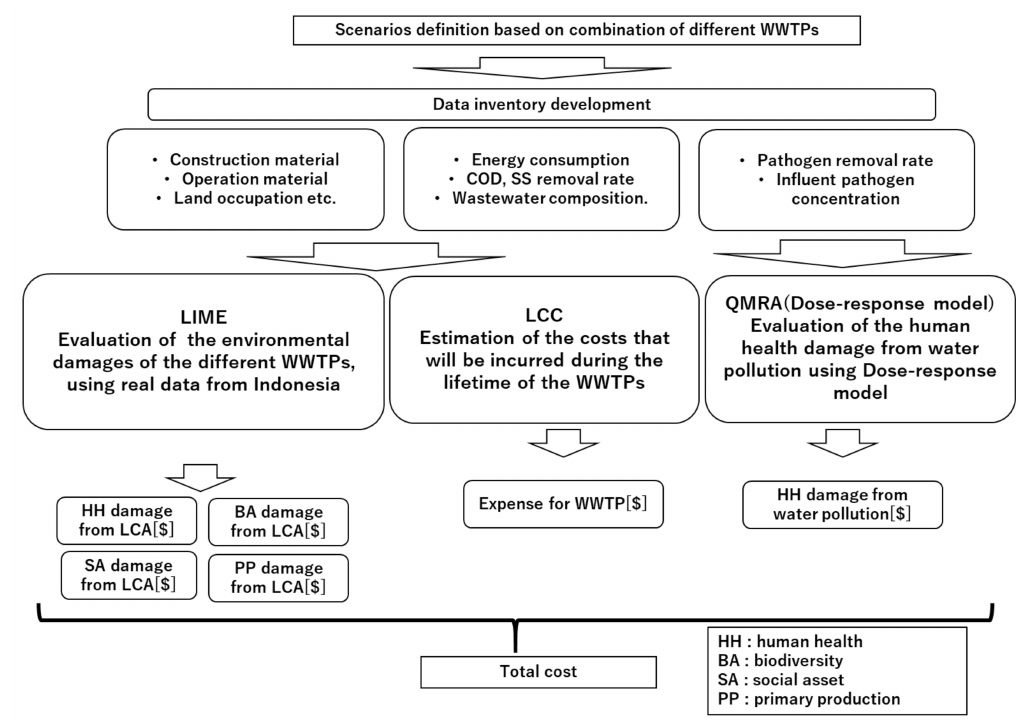
Figure 1. The conceptual modeling